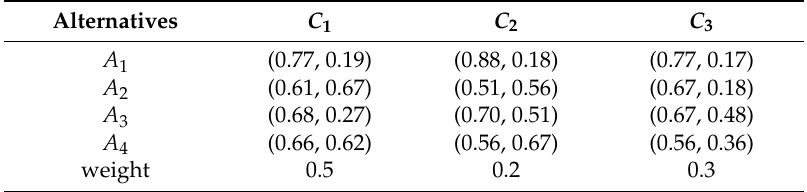
Table 8. The collective evaluation matrix of Internet stocks regarding each criterion [11].